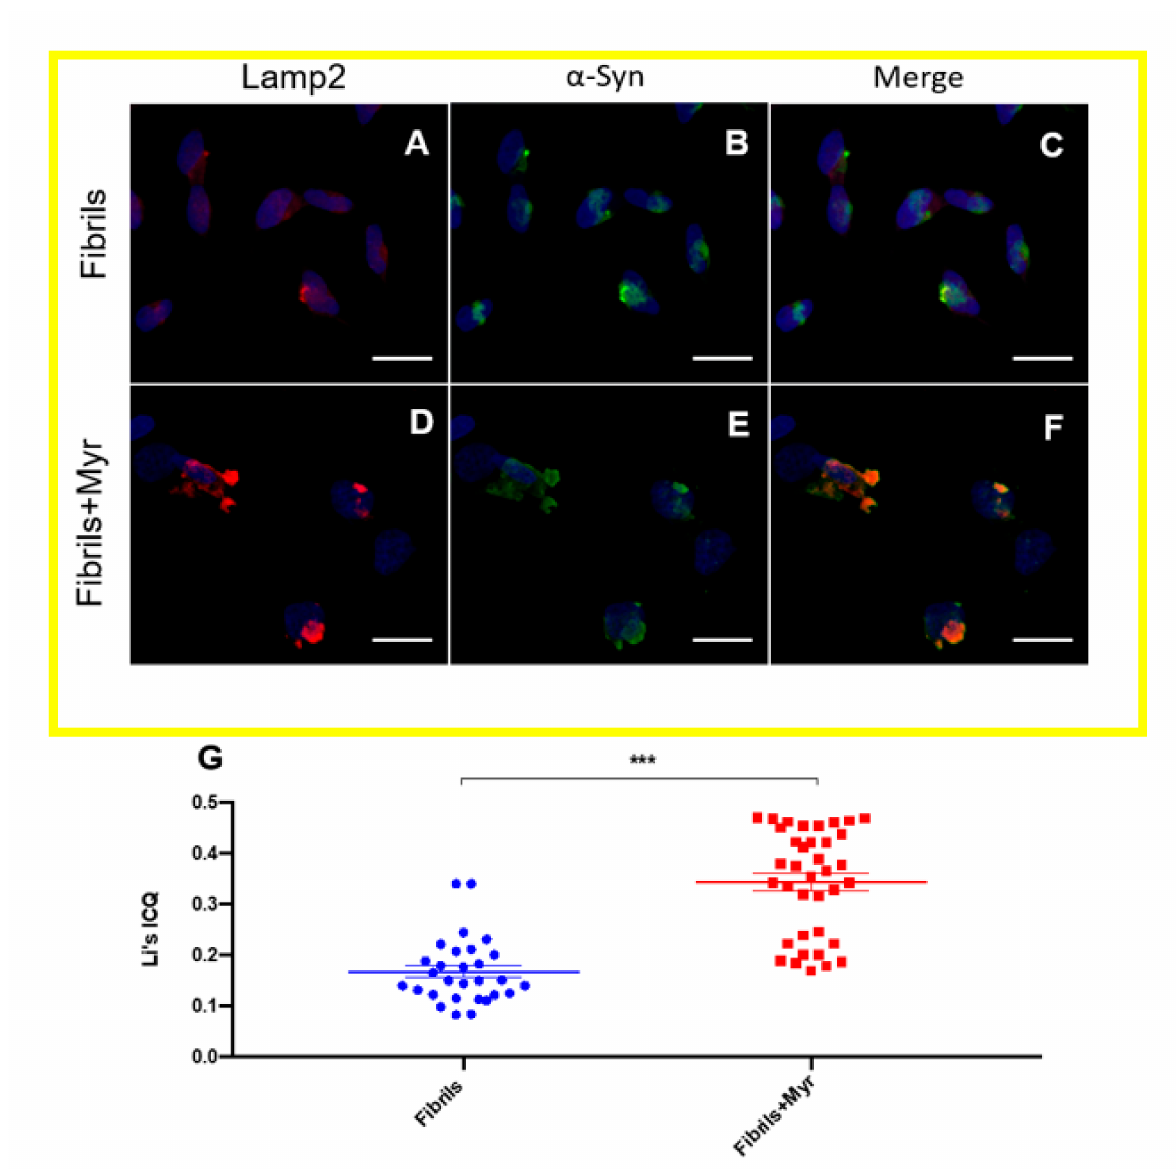
Figure 2. Myr induces co-localization of α -syn inclusions with the lysosomal marker. Confocal immunofluorescent images of SH-SY5Y cell line treated with 0.5 µ M α -syn fibrils for 24 h with or without 50 µ M Myr pretreatment. Confocal images were obtained after co-immunostaining of Lamp2 antibody (red, A , D ) and α -syn antibody (green, B , E ); co-localization in merge images is shown in yellow ( C , F ); DAPI (blue), nuclear counterstaining. Scale bars represent 20 µ m. ( G ) Graph of quantification of co-localizing fluorophores’ intensity (Li’s ICQ: intensity correlation quotient). Three independent experiments were performed; the cells corresponding to the dot number were randomly selected among 4 fields of each group. Data are presented as the intensity correlation of single cells (*** p <0.001); unpaired Student’s t -test was